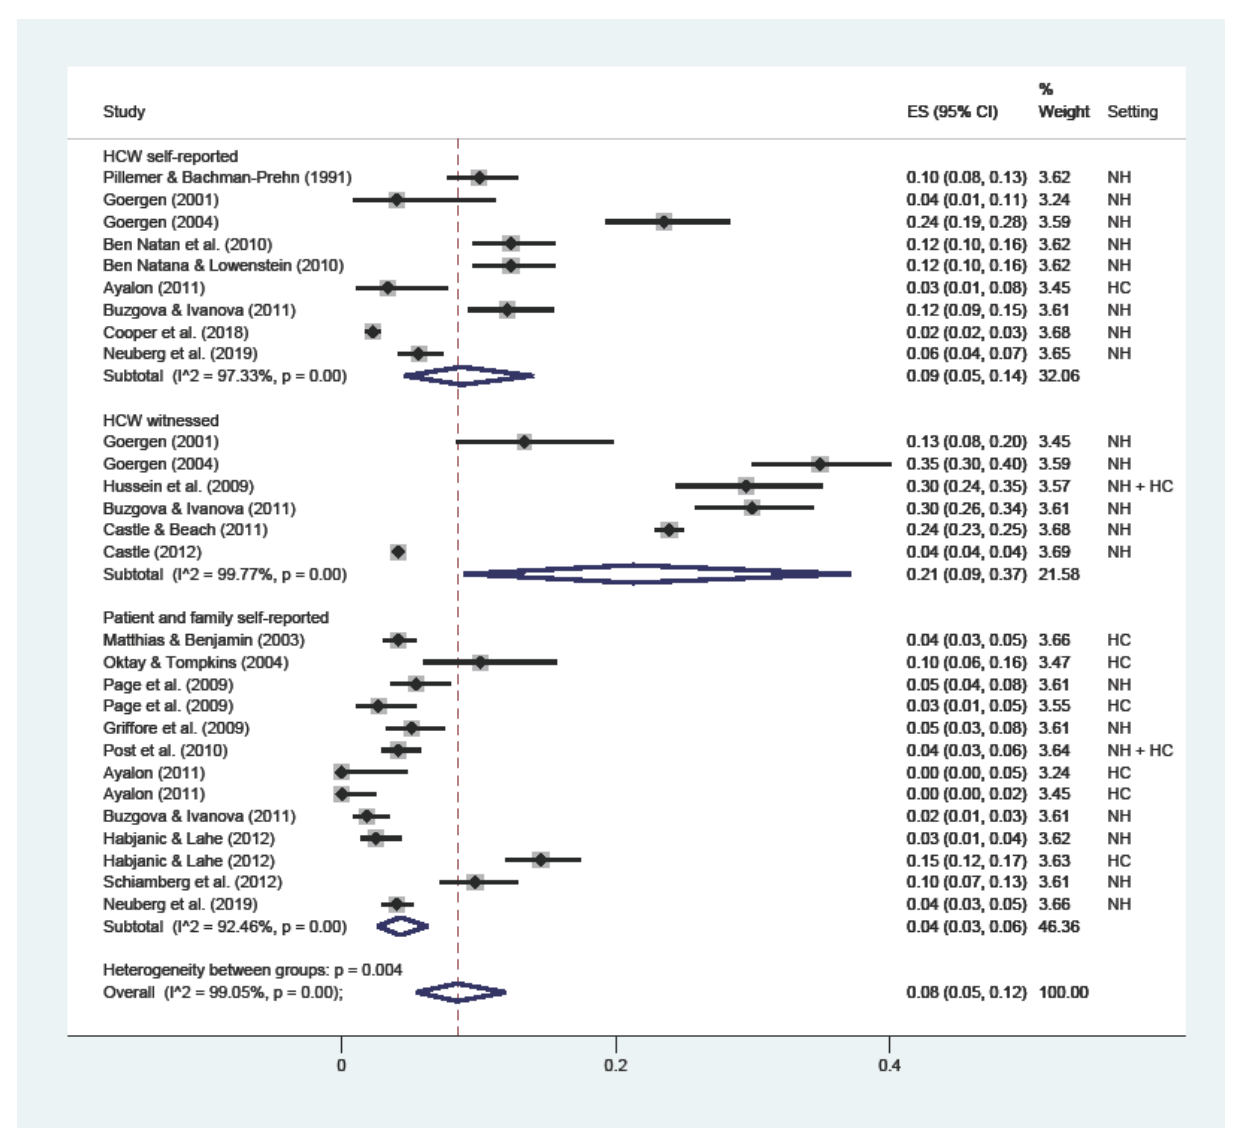
Figure 2. Forest plot of the prevalence of physical abuse in LTC. Subgroup meta-analyses by (Healthcare workers (HCW) self-reported, HCW witnessed, or patient and family self-reported). NH: nursing home; HC: home care.